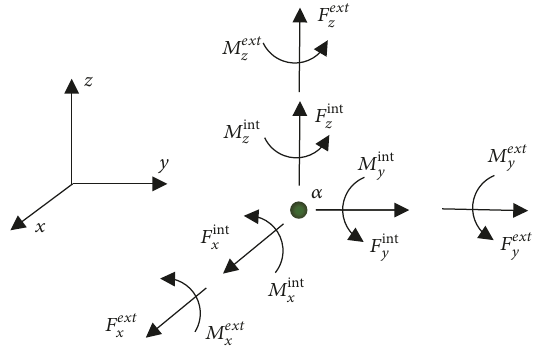
Figure 1: Loading onto space beam system